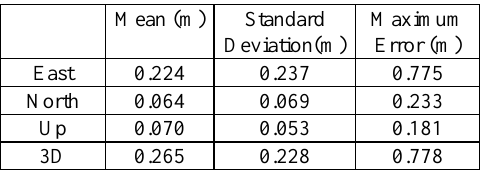
Table 3. Mapping solution accuracies using 6 or more images in East, North and Up